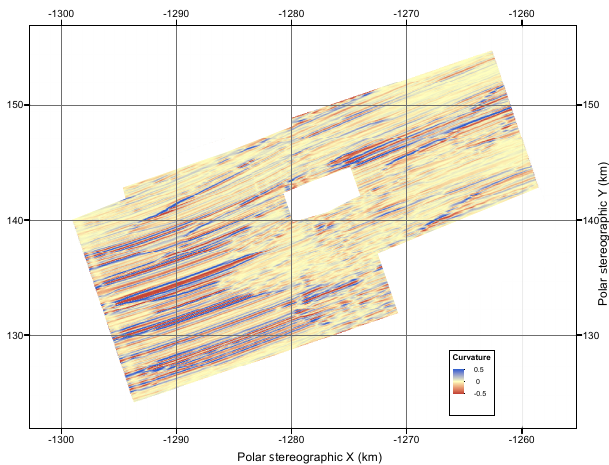
Figure 5. Map of the curvature of the bed elevation surface. This method of presenting the data emphasises the contrasts between high-amplitude linear features, low-amplitude linear features and low-amplitude features with low elongation. Positive values of cur- vature indicate upward convexity, and negative values upward con- cavity.